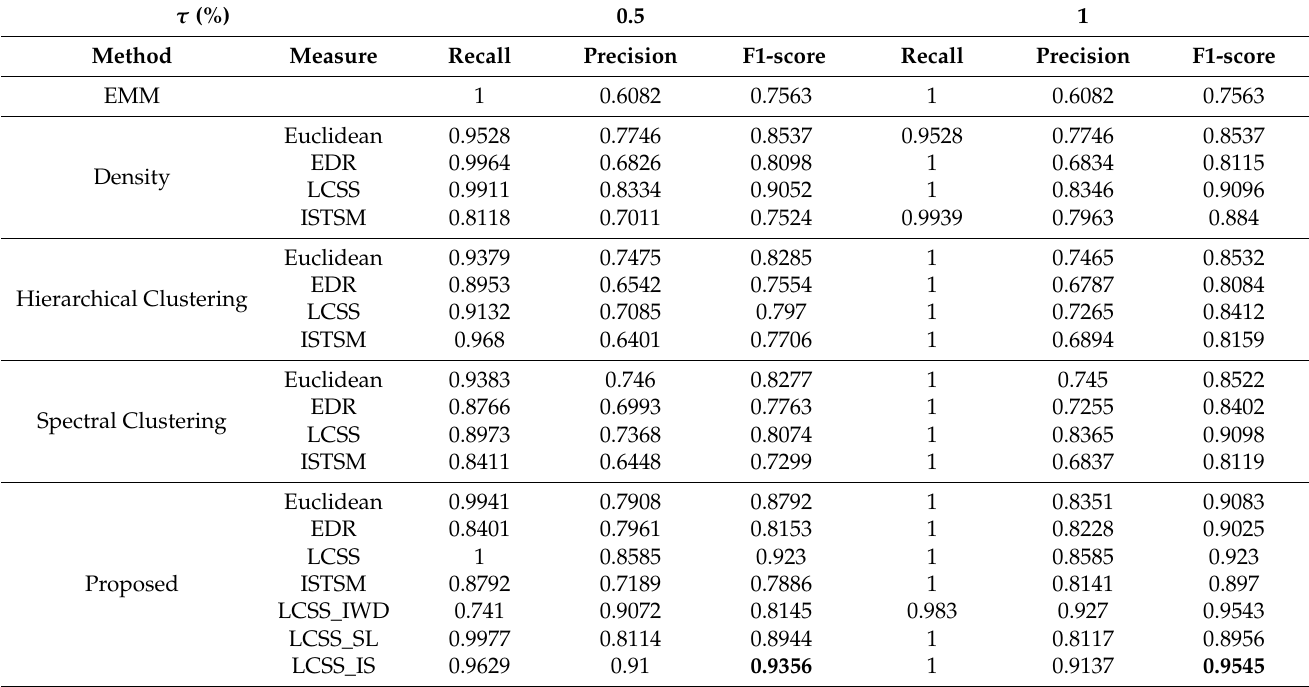
Table 3. Results with rare location visiting anomaly on the MIT Badge